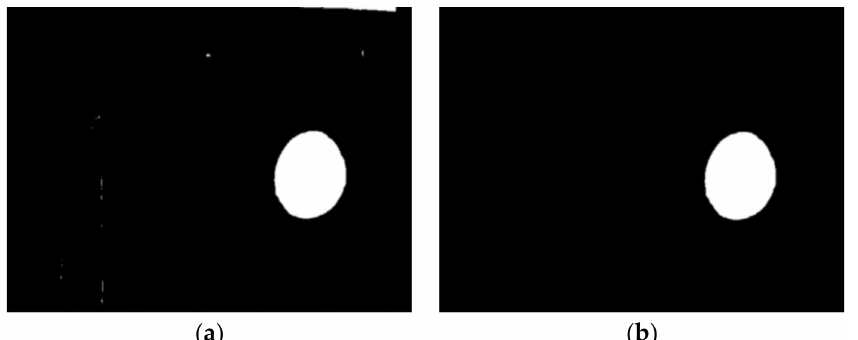
Figure 5. Processing effect before and after noise processing: ( a ) Effect before noise processing; noise is detected, which is presented as the white patches occurring at the middle and edge of the figure. ( b ) Effect after noise processing; unnecessary or redundant interfering information in the image data